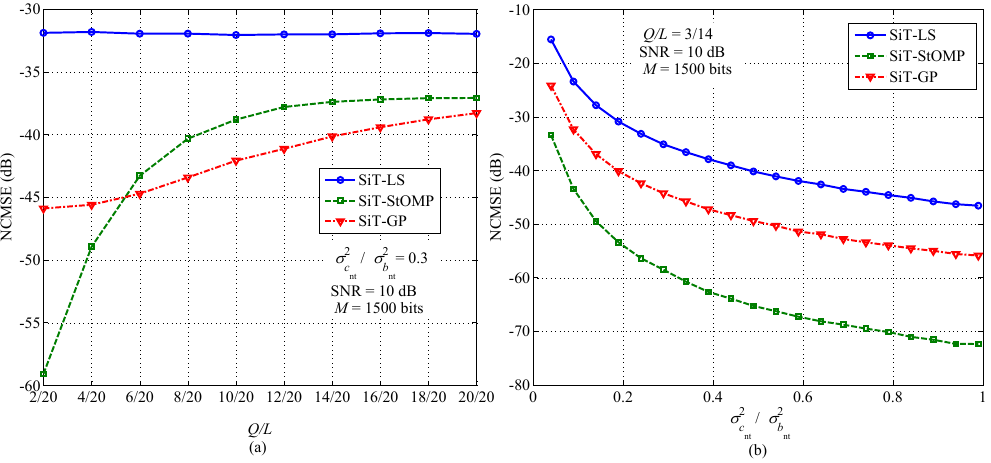
Figure 6. Performance comparison of SiT-StOMP, SiT-GP, and SiT least squares (SiT-LS) algorithms. ( a ) effect of channel’s sparsity; ( b ) effect of